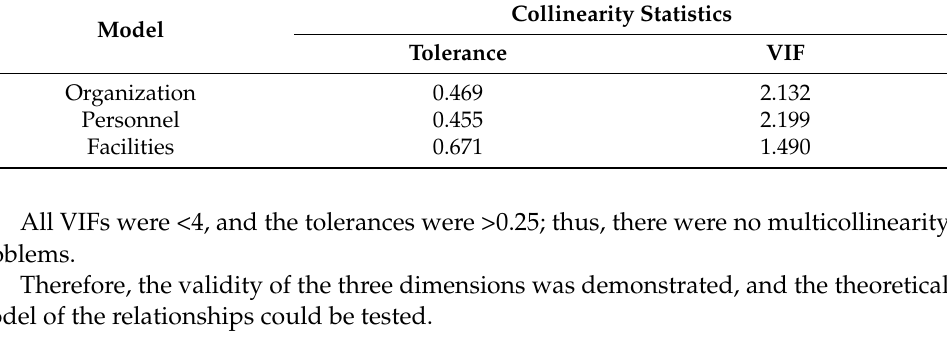
Table 6. Results of the regression analysis.